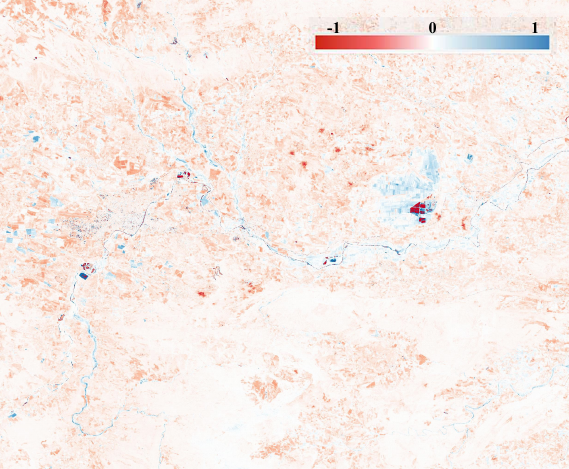
Figure 4 . 𝑅𝐷 (cid:3015)(cid:3005)(cid:3023)(cid:3010) between October 5 th and 25 th , 2018. Aude, France. Sentinel-2 (S2)